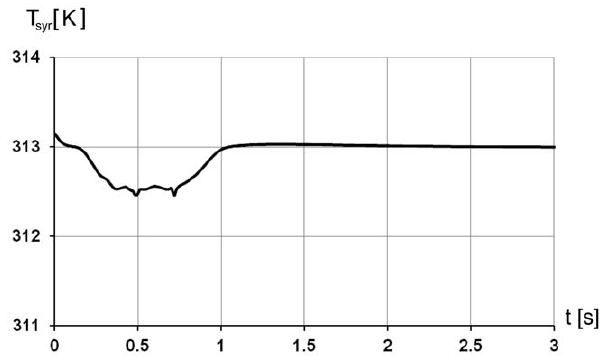
Figure 6. Temperature in syrinx averaged over the cross- sectional area during the breathing cycle. 1 s corresponds to end- inspiration.